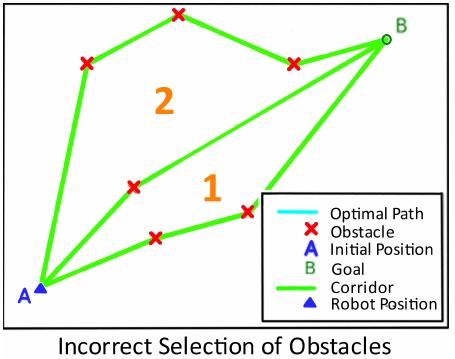
Figure 4. Selection of too many obstacles leads to the selection of multiple corridors.